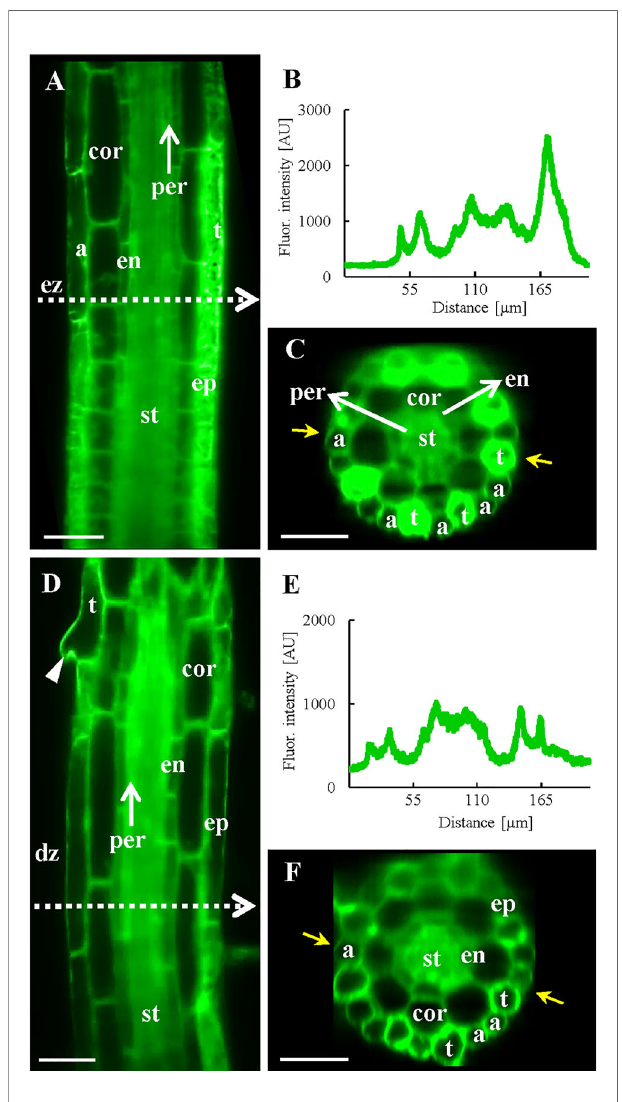
FIGURE 4 | In vivo localization of ANN1-GFP in elongation and differentiation zone of the primary root in A. thaliana expressing proANN1::ANN1:GFP construct using LSFM. (A) Medial optical section of the elongation zone shows tissue-speci fi c localization pattern of ANN1-GFP, with higher amount in trichoblasts (t) in comparison to atrichoblasts (a) of the epidermis (ep), lowering of the ANN1-GFP content in vacuolated cortical cells (cor) and in endodermal cells (en), and rather homogenous distribution in the stele (st) and pericycle (per) cells. White dashed arrow indicates the position where the fl uorescence intensity pro fi le has been measured. (B) The fl uorescence intensity along the pro fi le shown in (A) and yellow arrows in (C) . (C) The corresponding orthogonal projection of the radial root section at the position of the intensity pro fi le in (A) . (D) Medial optical section of the differentiation zone with the strongest level of ANN1-GFP production in the stele (st) and decreased amount in vacuolated cells of endodermis (en), cortex (cor), and epidermis (ep). Trichoblast with emerged root hair is marked by an arrowhead. White dashed arrow indicates the position where the fl uorescence intensity pro fi le has been measured. (E) The fl uorescence intensity along the pro fi le shown in (D) and yellow arrows in (F) . (F) The corresponding orthogonal projection of the radial root section at the position of the intensity pro fi le in (D) . Scale bars = 50